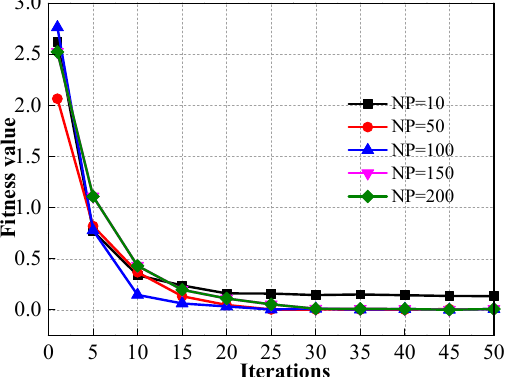
Figure 11. Iteration curve of different populations.